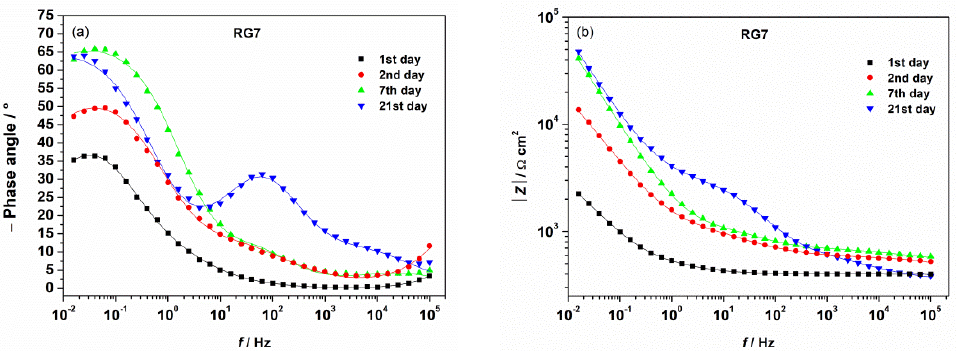
Figure 8. EIS spectra for CuSn6 bronze for continuous immersion in artificial urban rain at pH 6.5. ( a ) Bode phase angle; ( b ) Bode impedance.